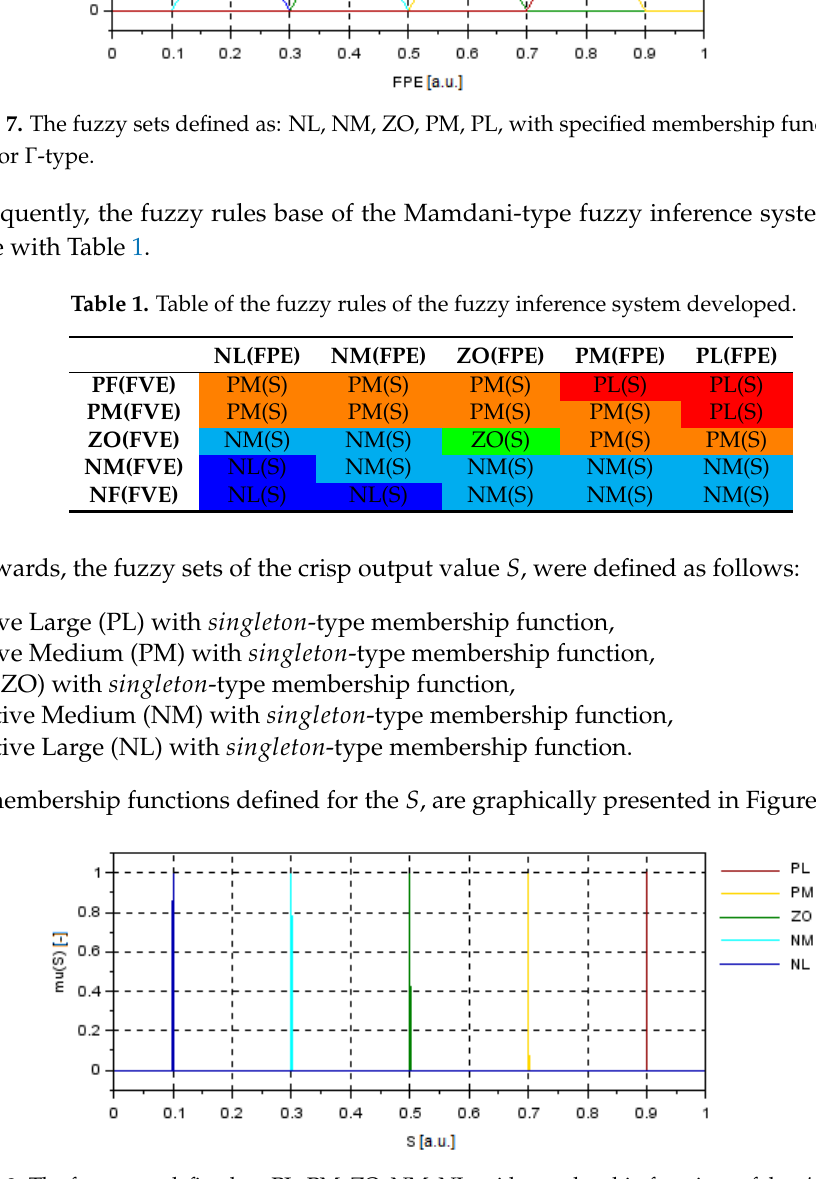
Figure 8. The fuzzy sets defined as: PL, PM, ZO, NM, NL, with membership functions of the singleton